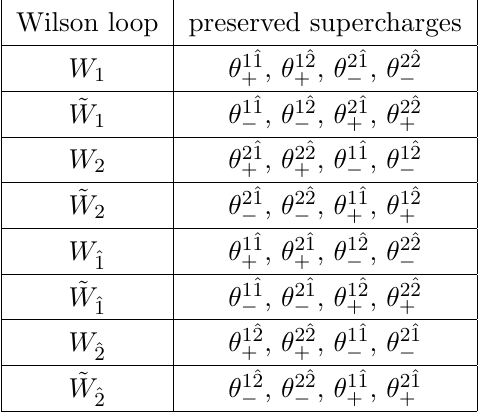
Table 4. The 1/2 BPS WLs in N = 4 orbifold ABJM theory and the supercharges they